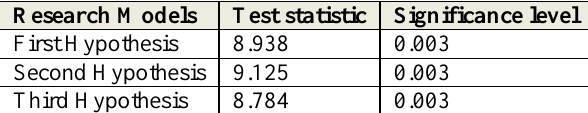
Table 10. Serial Autocorrelation Test Results